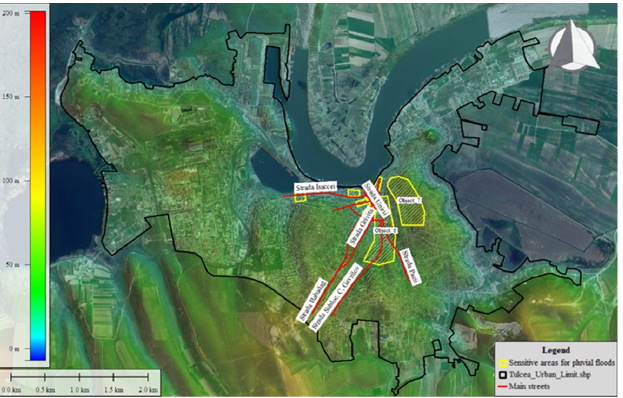
Figure 5. Most sensitive areas (yellow) and the pluvial drainage system.